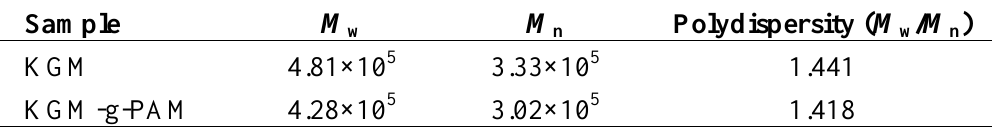
Table 1 . The molecular weight and polydispersity of KGM and